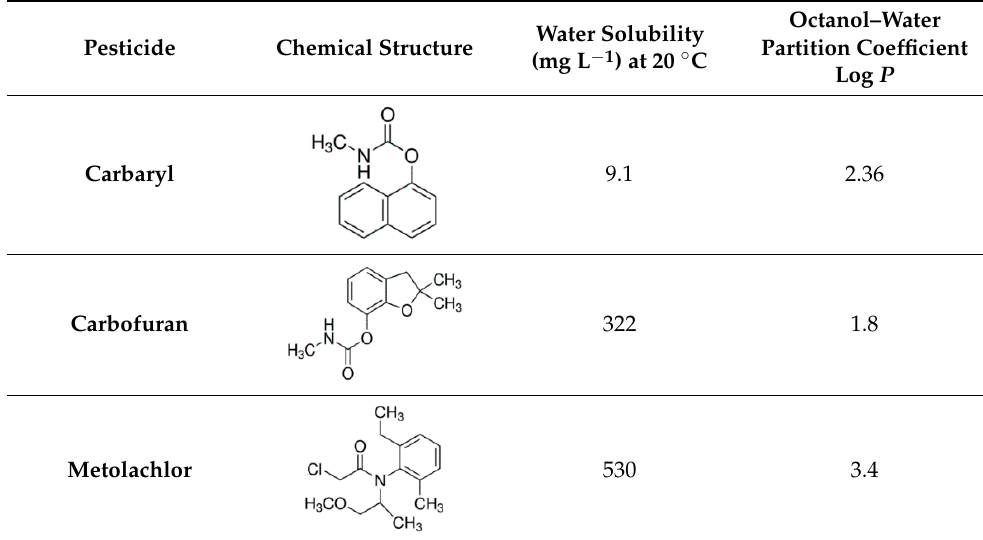
Table 1. Basic properties of pesticides under study * [40].